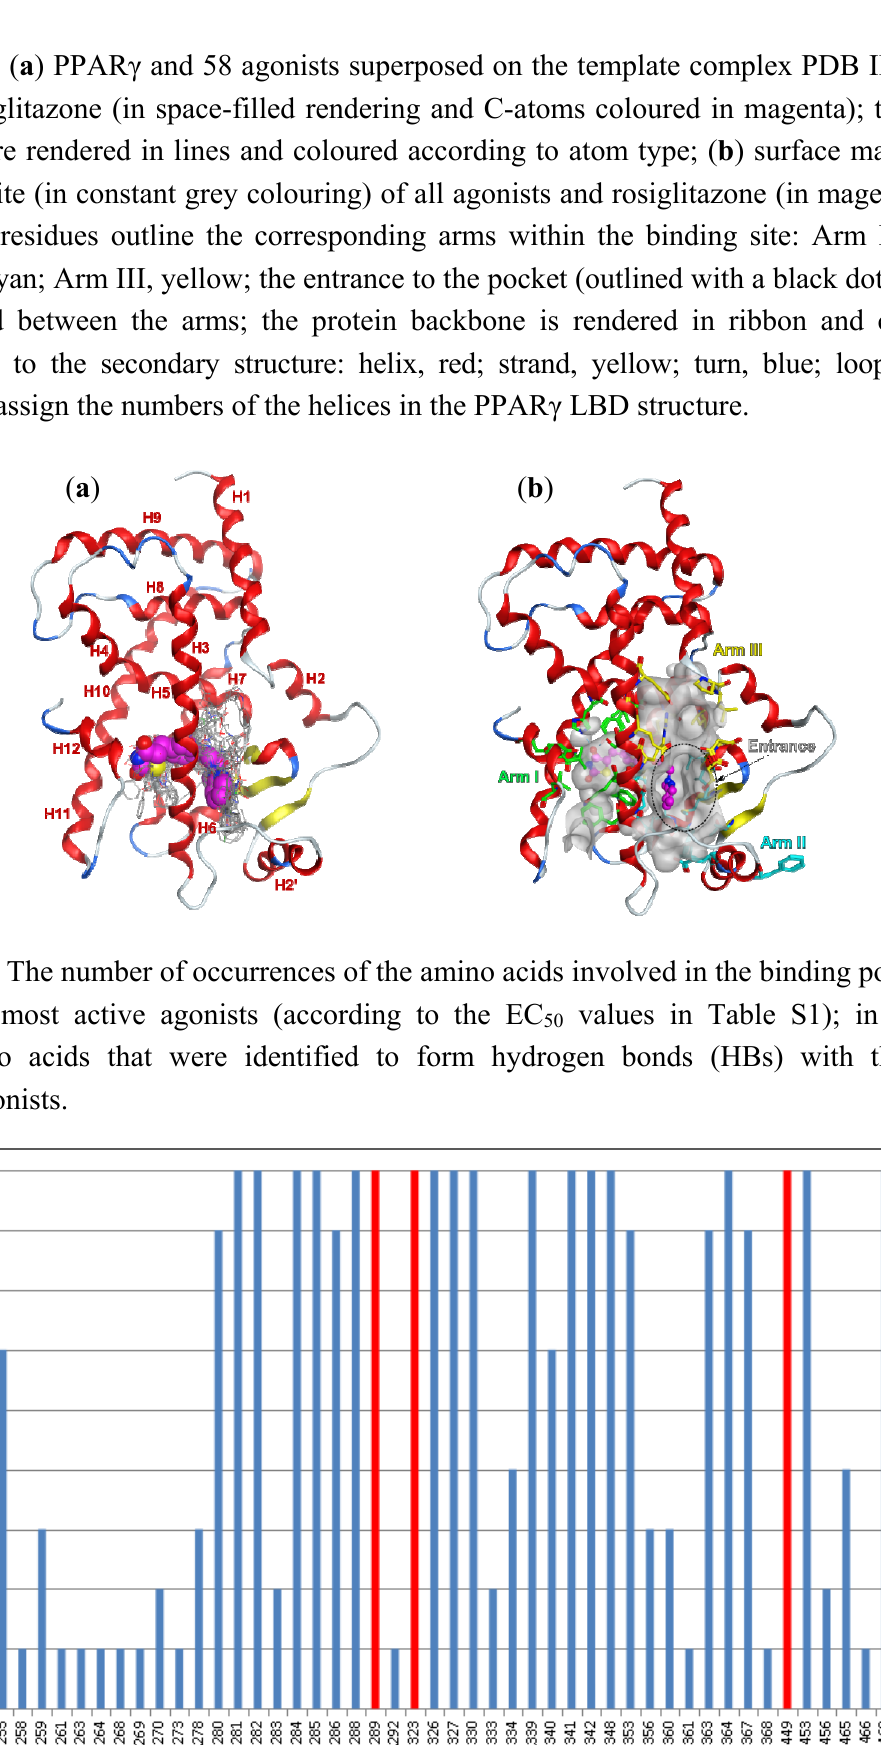
Figure 4. ( a ) PPAR γ and 58 agonists superposed on the template complex PDB ID 1FM6 with rosiglitazone (in space-filled rendering and C-atoms coloured in magenta); the other ligands are rendered in lines and coloured according to atom type; ( b ) surface map of the binding site (in constant grey colouring) of all agonists and rosiglitazone (in magenta); the coloured residues outline the corresponding arms within the binding site: Arm I, green; Arm II, cyan; Arm III, yellow; the entrance to the pocket (outlined with a black dotted line) is located between the arms; the protein backbone is rendered in ribbon and coloured according to the secondary structure: helix, red; strand, yellow; turn, blue; loop, white; H1–H12 assign the numbers of the helices in the PPAR γ LBD structure.